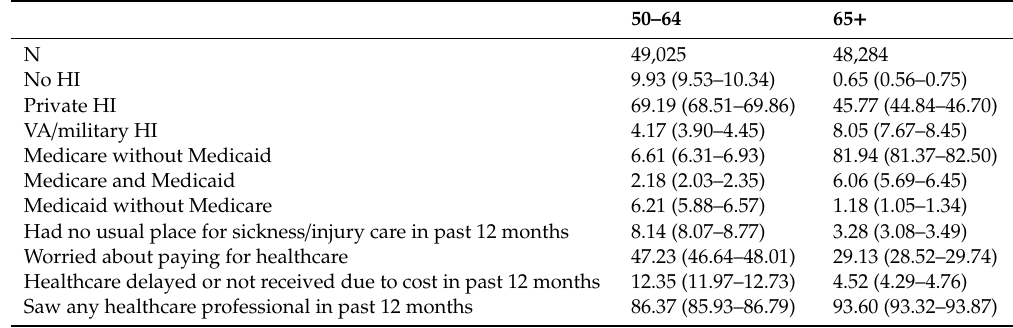
Table 1. Health insurance (HI) coverage, healthcare access, and healthcare cost worry among the 50–64 age group versus the 65 + age group, % (95% confidence interval).